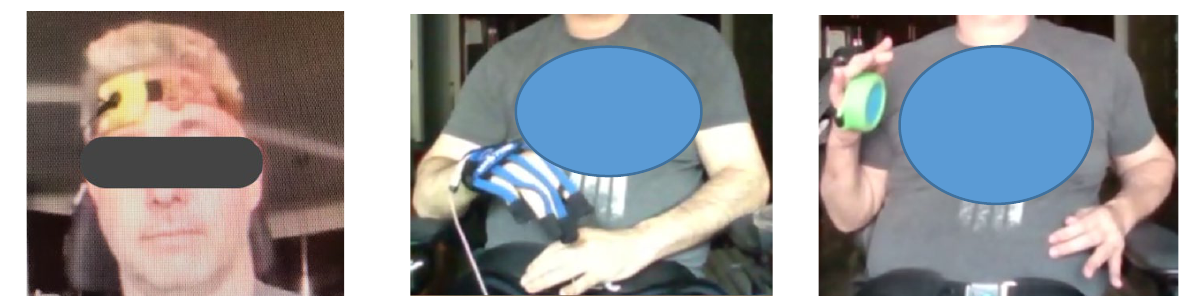
Figure 1. Image of a Patient with tDCS and the 2-Exercise Equipment in a Real-Time, remotely Supervised Treatment Session.